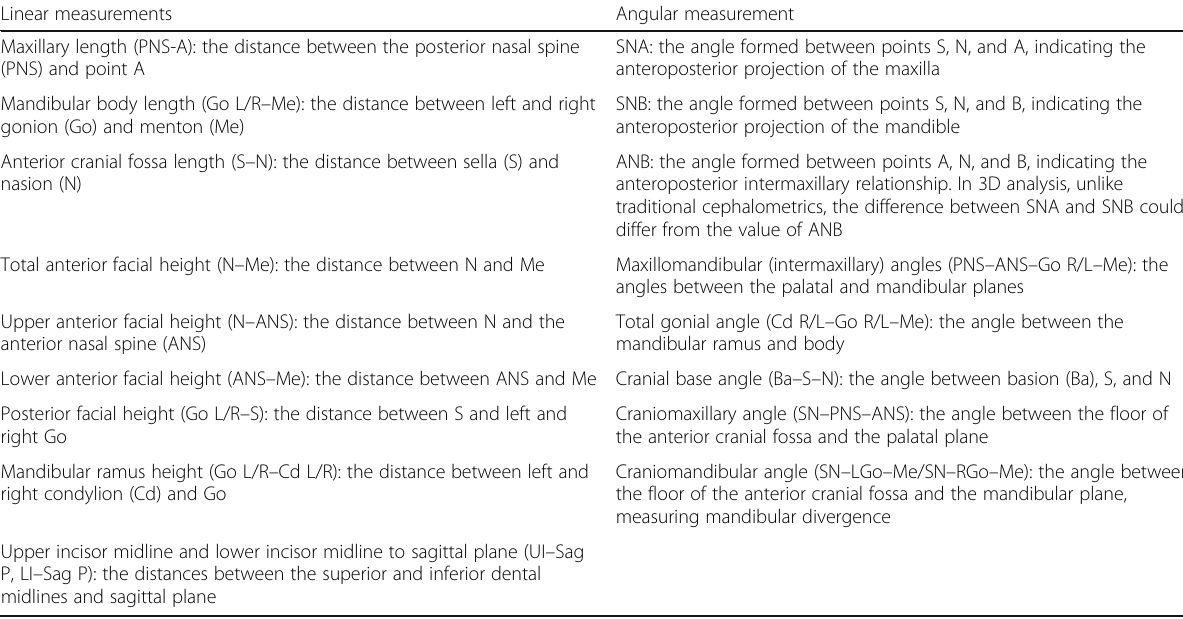
Table 1 Definition of the cephalometric measurements performed in the present study Linear measurements Angular